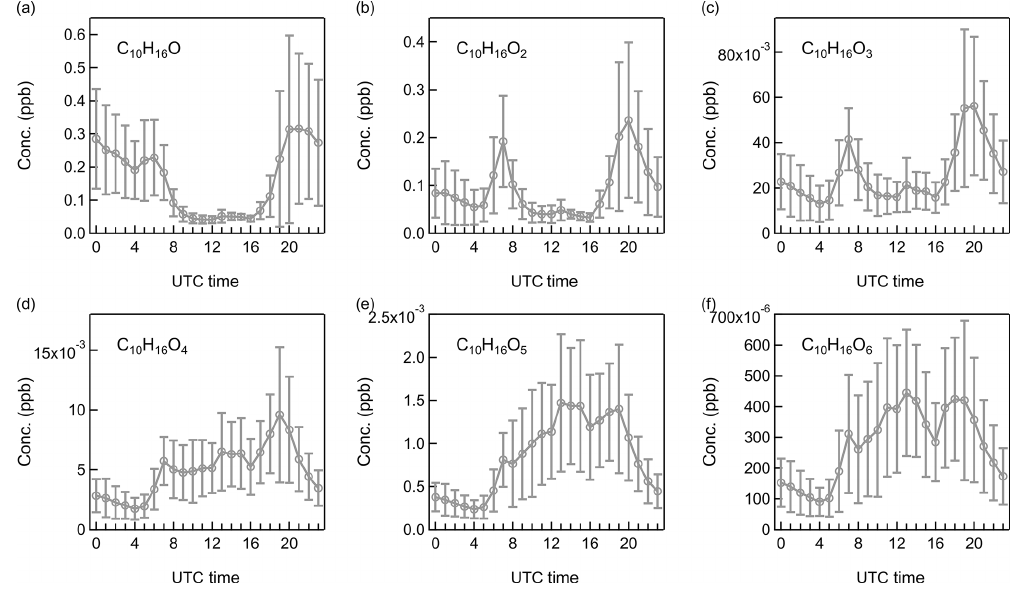
Figure 8. Diurnal patterns of non-nitrate monoterpene oxidation products: (a) C 10 H 16 O, (b) C 10 H 16 O 2 , (c) C 10 H 16 O 3 , (d) C 10 H 16 O 4 , (e) C 10 H 16 O 5 , and (f) C 10 H 16 O 6